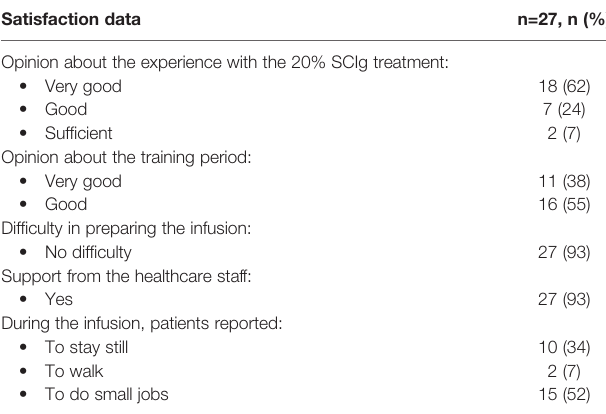
TABLE 6 | Satisfaction data in CVID patients. Satisfaction